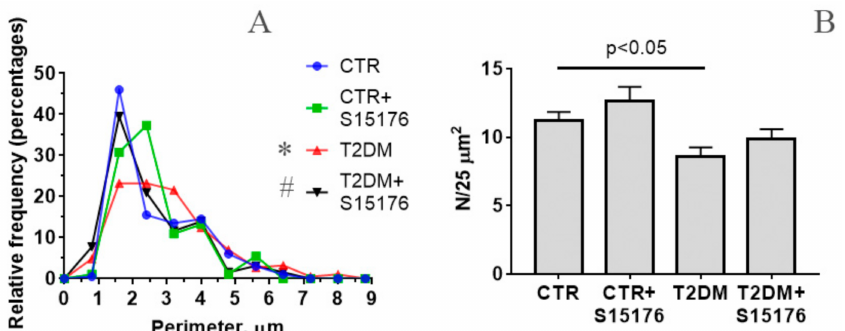
Figure 3. Morphometric parameters of liver mitochondria from experimental mice: ( A ) a histogram of distribution of the mitochondrial perimeter in the groups. The number of mitochondria analyzed in each group varies from 100 to 200. Statistical significance was estimated by the Kruskal-Wallis test: * p < 0.05 compared to the CTR group. # p < 0.05 compared to the T2DM group; ( B ) the number of mitochondria per field of view (25 µ m 2 ). The number of examined fields of view (25 µ m 2 ) in the groups varies from 15 to 25. The di ff erences were considered statistically significant at p < 0.05.